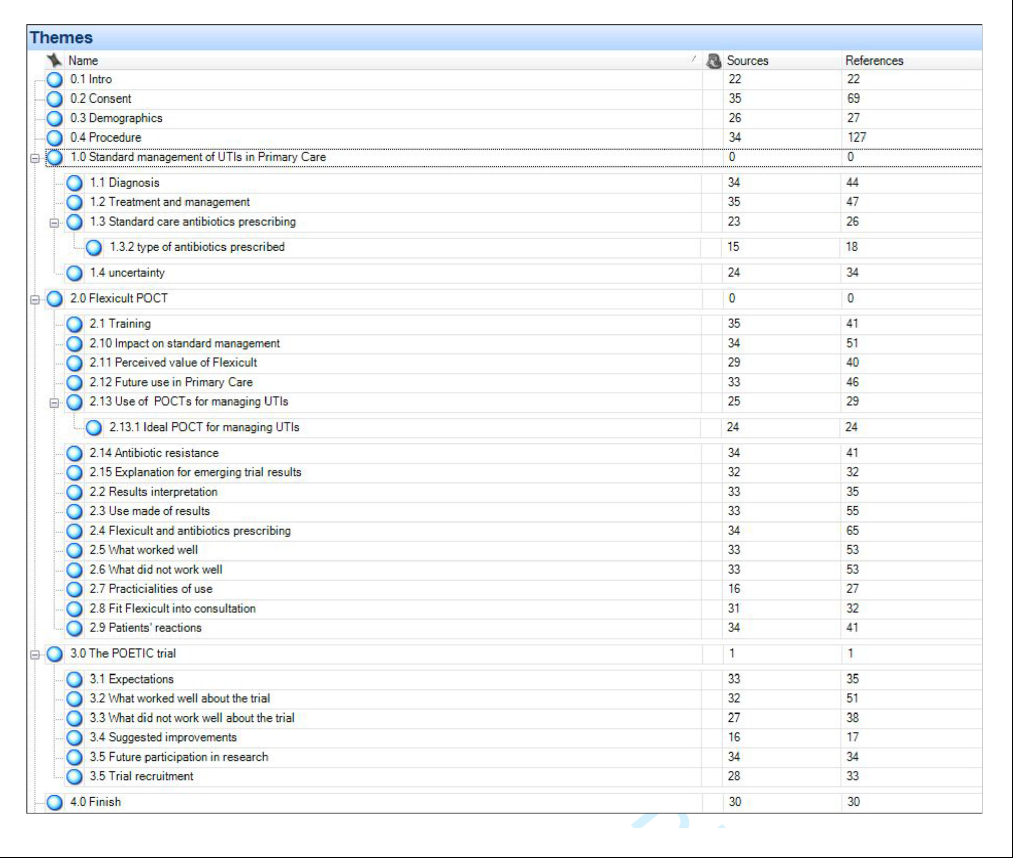
Figure 1. Thematic framework developed to analyse interview